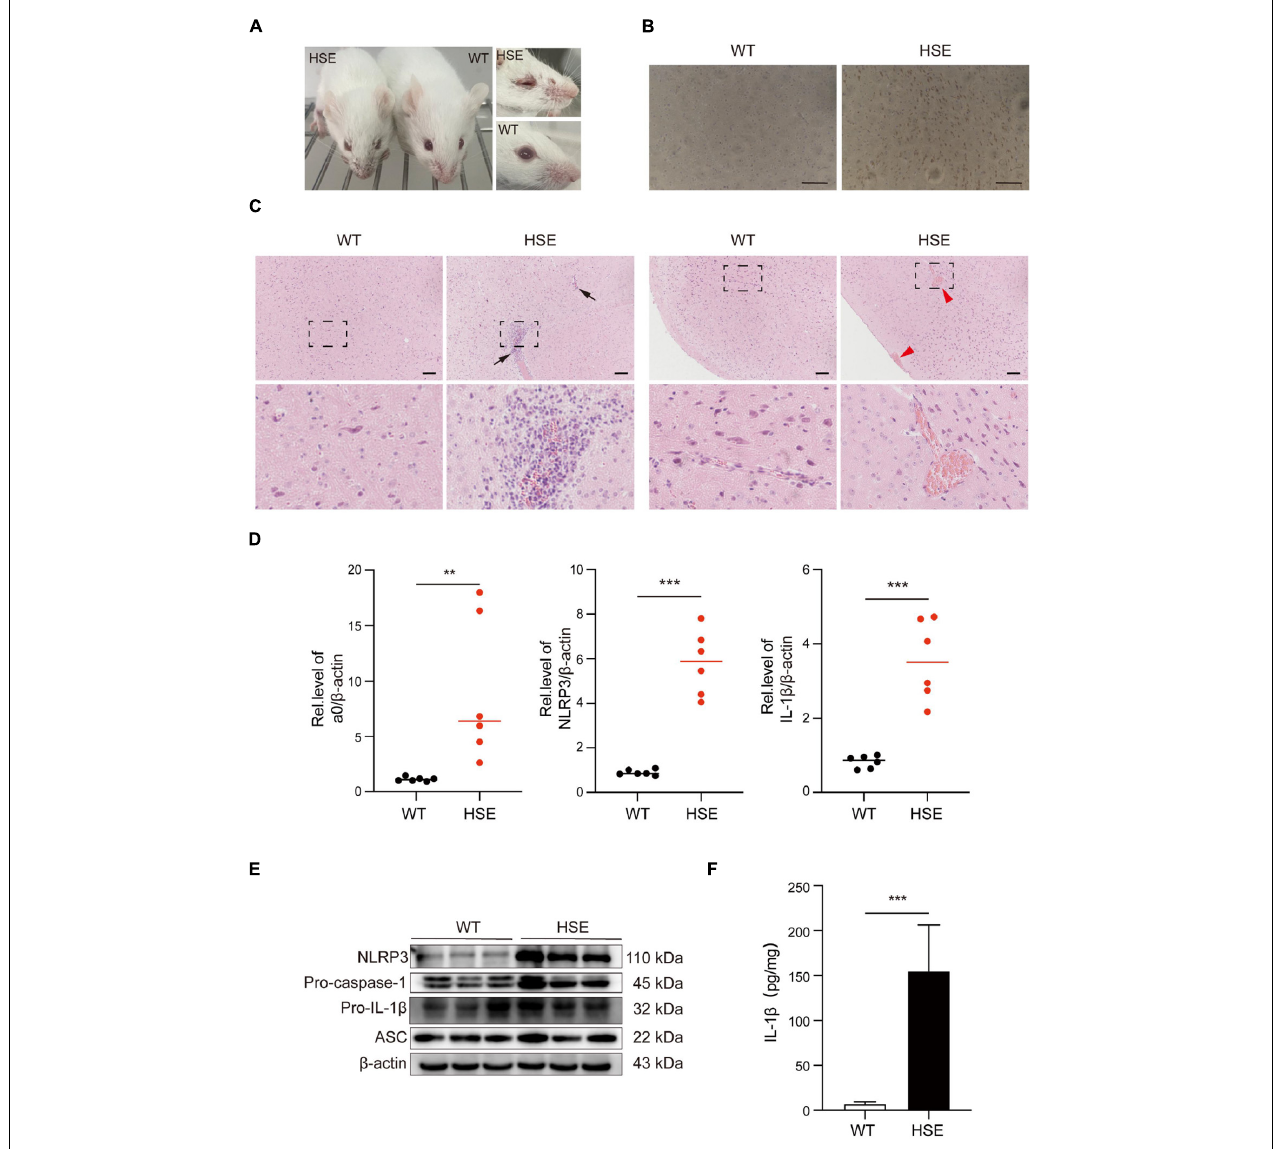
FIGURE 5 | HSV-1 infection triggers severe pathology in the brain. (A) Photos of the front and eyes of mice in the normal and virus-infected groups. (B) Immunohistochemical micrographs of brain sections stained with HSV-1 (Scale bars, 100 µ m). (C) Histopathological micrograph of H&E staining of the cerebral cortex (8 dpi). Black arrow: immune cell infiltration; red arrow: perivascular cuff (Scale bars, 100 µ m). (D) The qRT-PCR method was used to detect the transcript levels of viral genes a0, NLRP3, and IL-1 β in mouse brain specimens (8 dpi) ( n = 6). (E) The protein of NLRP3, Pro-caspase-1, Pro-IL-1 β , and ASC in mouse brain specimens was detected by Western blot analysis (8 dpi). (F) ELISA was used to detect IL-1 β in mock-infected and HSV-1 infected mice sera. All data are presented as mean ± SD, Student’s t -test, ** P < 0.01, *** P <